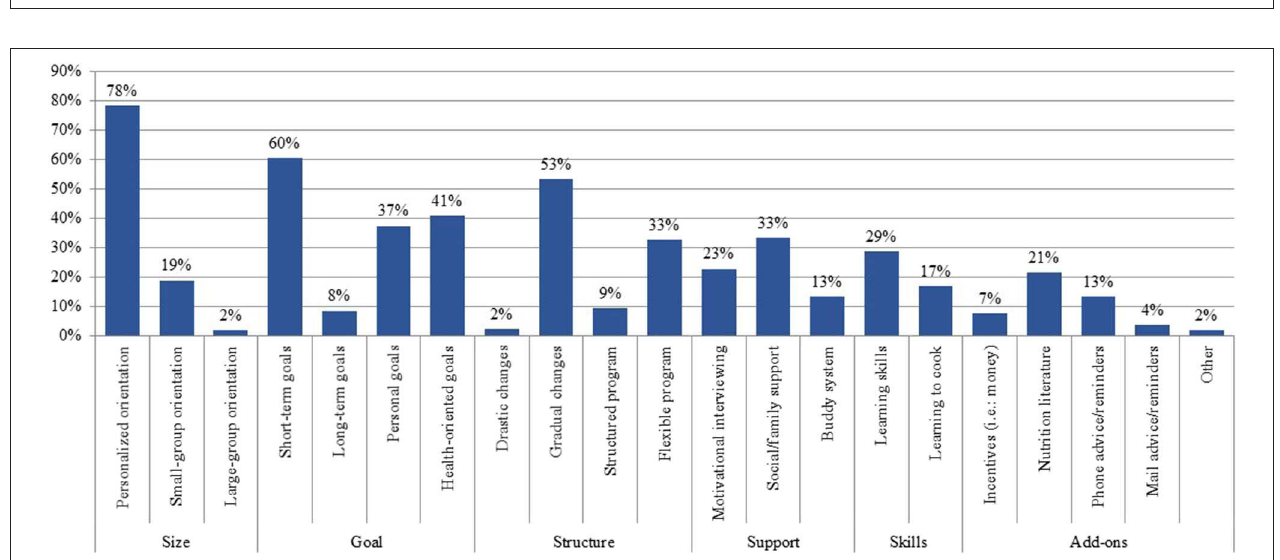
FIGURE 1 | Food or nutrients perceived by nutrition professionals as part of the diet of their patients/clients. Shown as percentages from 414 nutrition professionals surveyed in Puerto Rico that perceive the food or nutrient as difficult to control (A) or as easy to include (B) in the diet of their patients/clients.